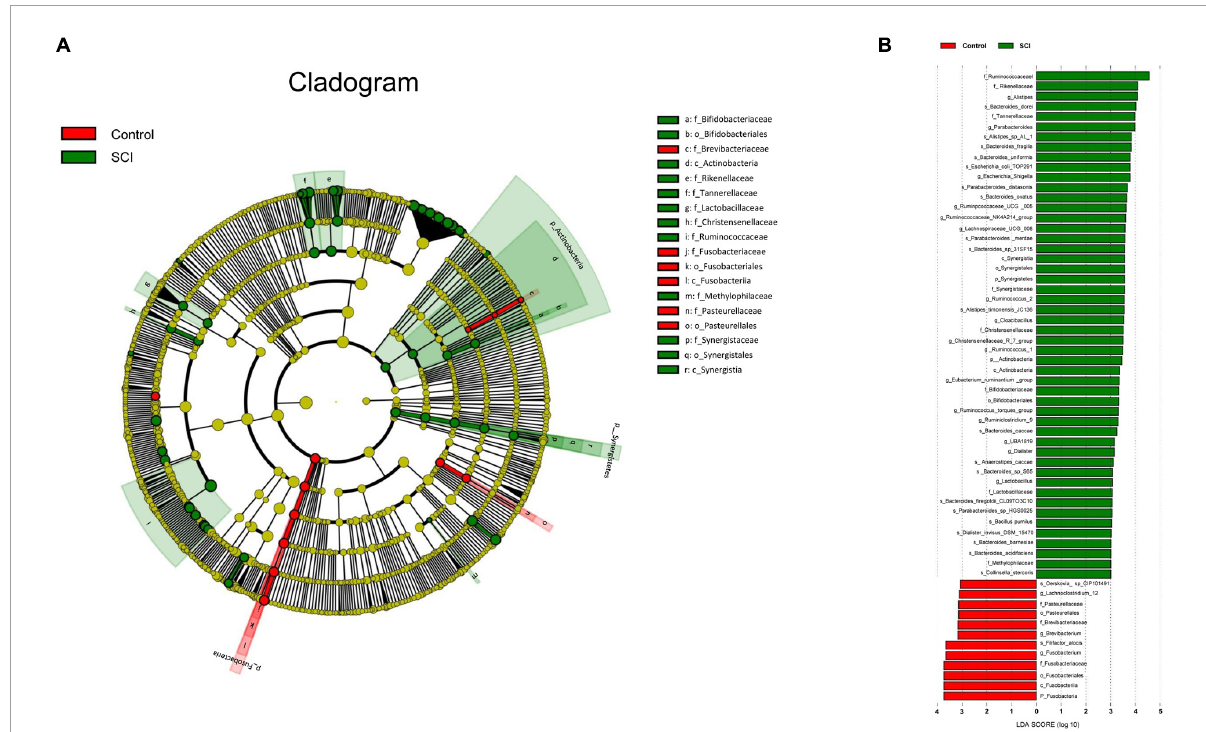
FIGURE6 Taxonomic differences of gut microbiota in SCI and healthy groups. (A) Cladogram using LEfSe (Linear discriminant analysis effect size) method, which indicates the phylogenetic distribution of gut microbiota associated with SCI and healthy subjects. (B) LEfSe analysis revealed significant bacterial differences in gut microbiota between the SCI (positive score) and healthy groups (negative score). The LDA scores (log10) > 2 and P < 0.05 are